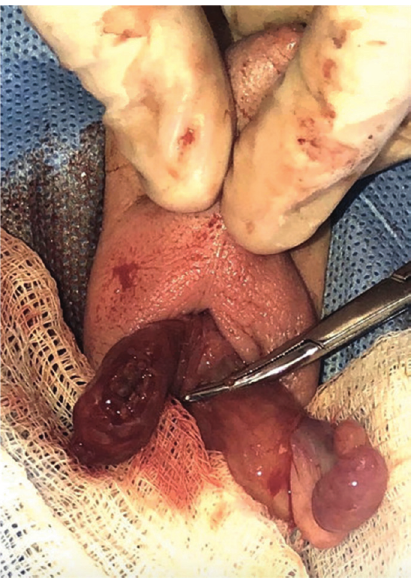
Figure 3: The incision of the scrotum along the raphe, revealing a discolored, edematous, and necrotic right testicle, with normal appearance of the left testicle. Orchiectomy of the right testicle was followed by contralateral orchiopexy.